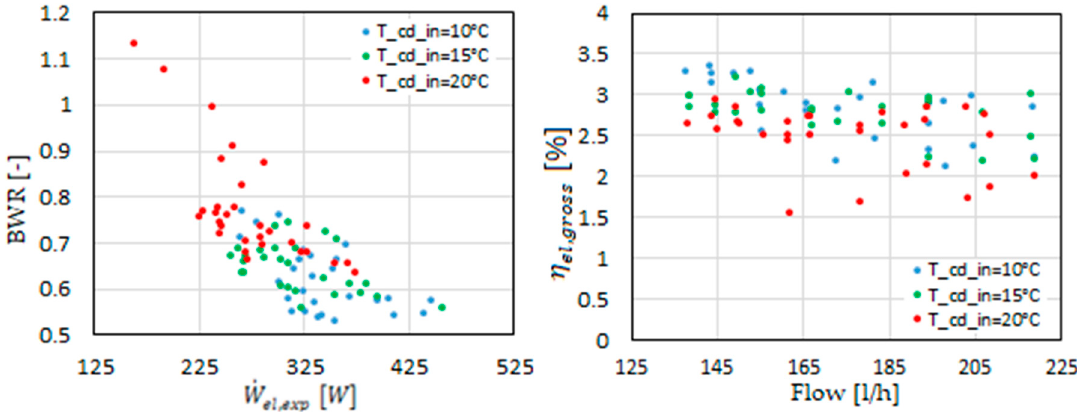
Figure 10. Pump back-work ratio (BWR) with expander produced electric power ( left ), and ORC system gross efficiency with flow rate ( right ).